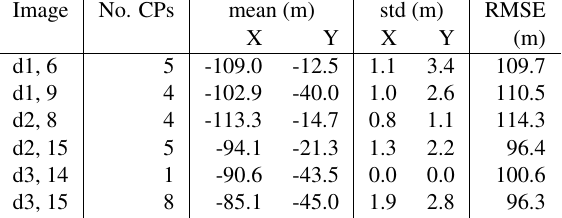
Table 2: Planimetric GCP errors after relative RPC bundle block adjustment.